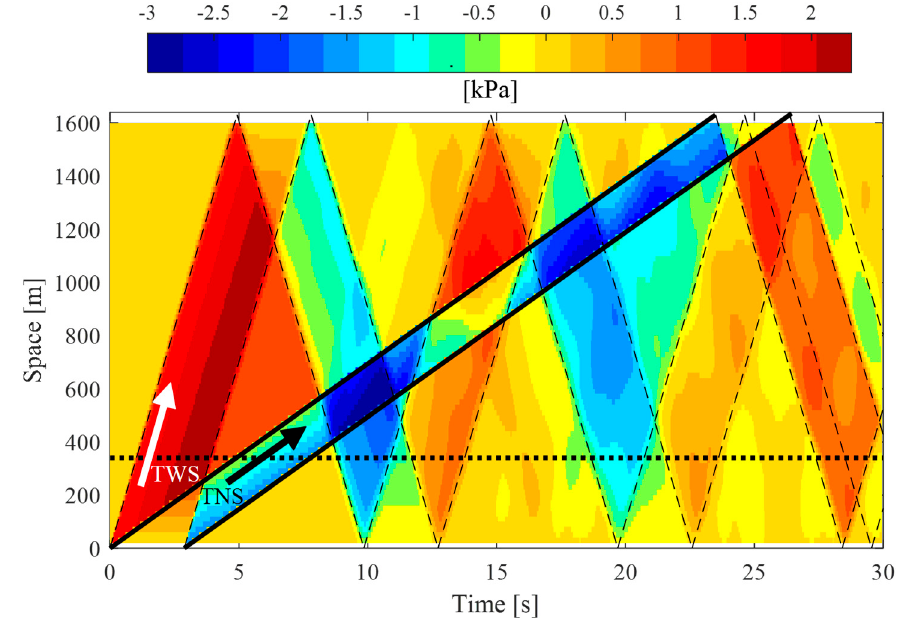
Figure 1. Time-space representation of the pressure evolution within a 1640 m long tunnel crossed by a 200 m long train running at 250 km / h. Solid lines represent the head and tail of the train, the horizontal dotted line represents a sensor at 340 m from the entrance, the dashed lines represent the pressure waves generated by the train.